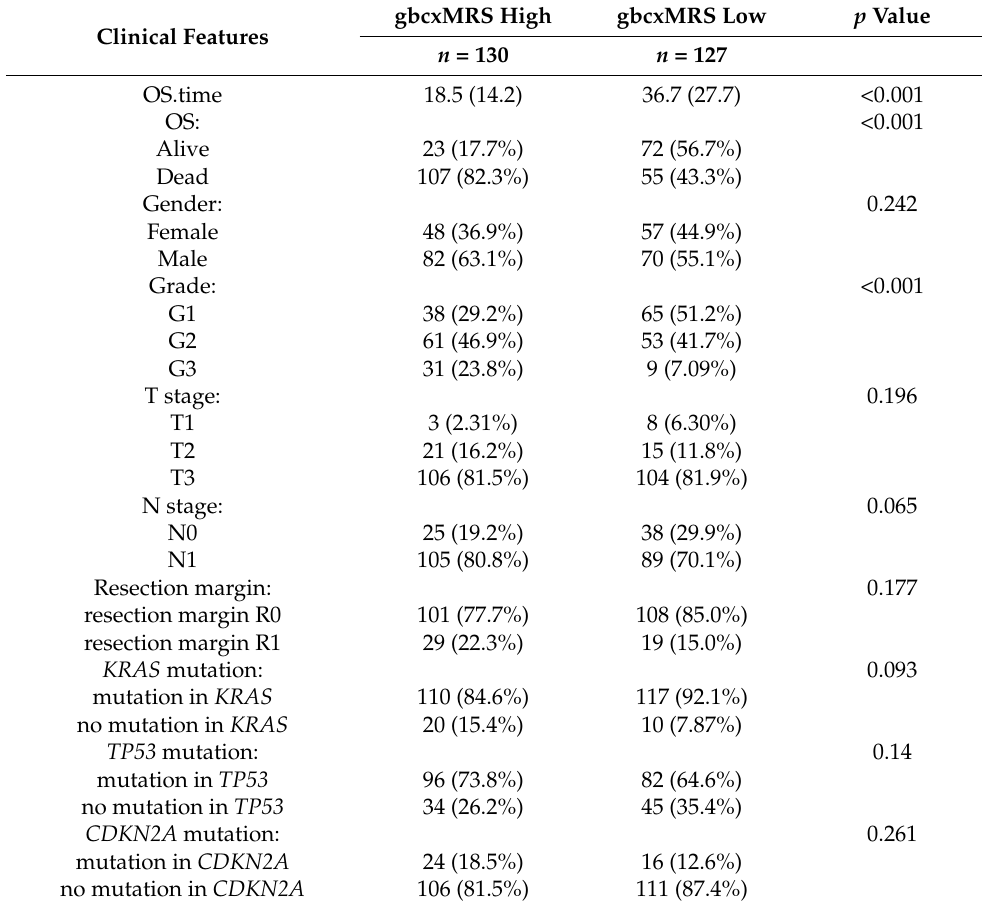
Table 1. Comparison of clinical features between the high and low gbcxMRS groups in the E-MTAB- 6134 cohort.